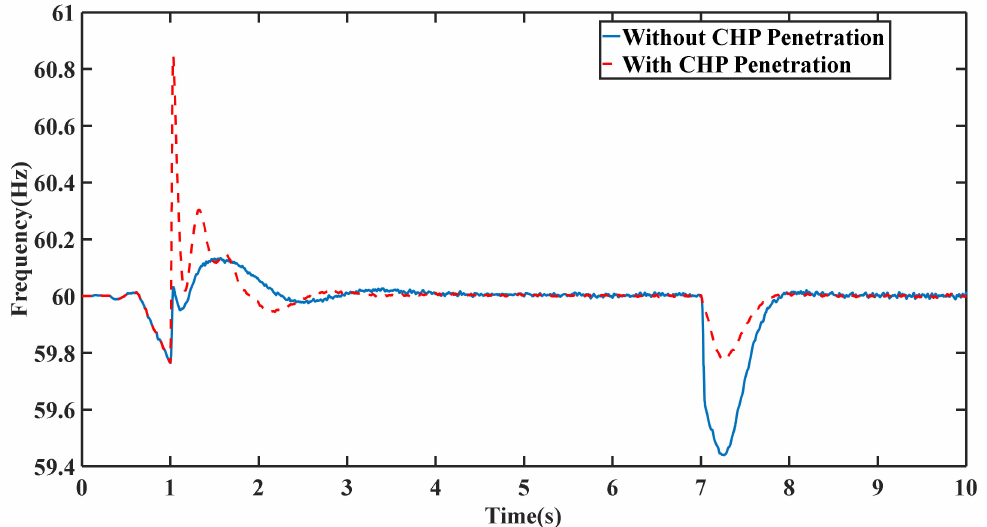
Figure 11. Frequency deviation with and without CHP